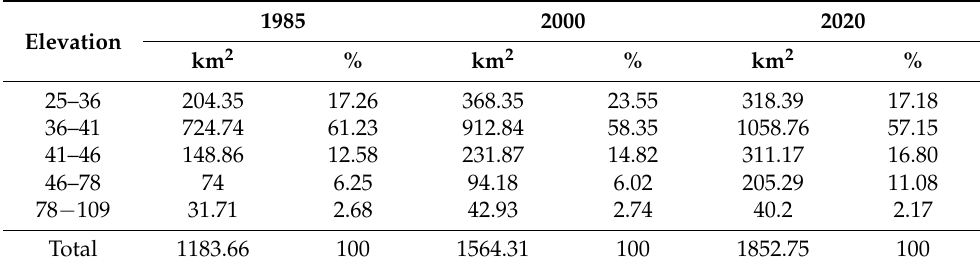
Table 6. Urban CL growth based on elevation (in meters) from 1985 to 2020.